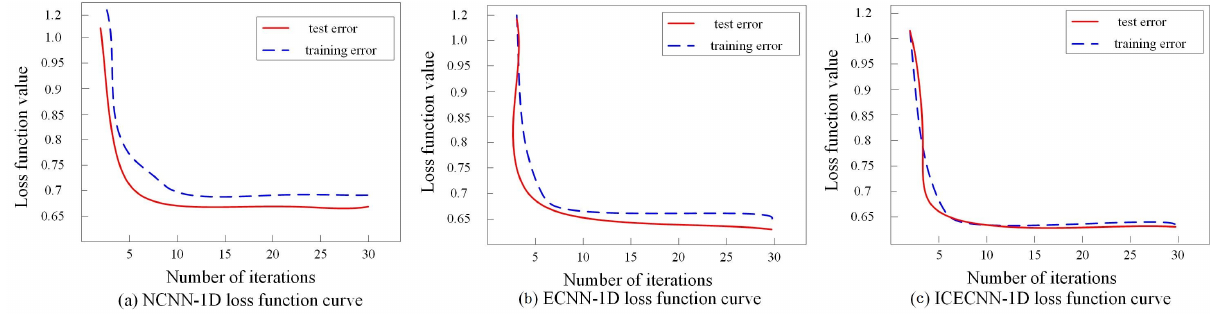
Figure 5. Trend chart of the three models’ loss